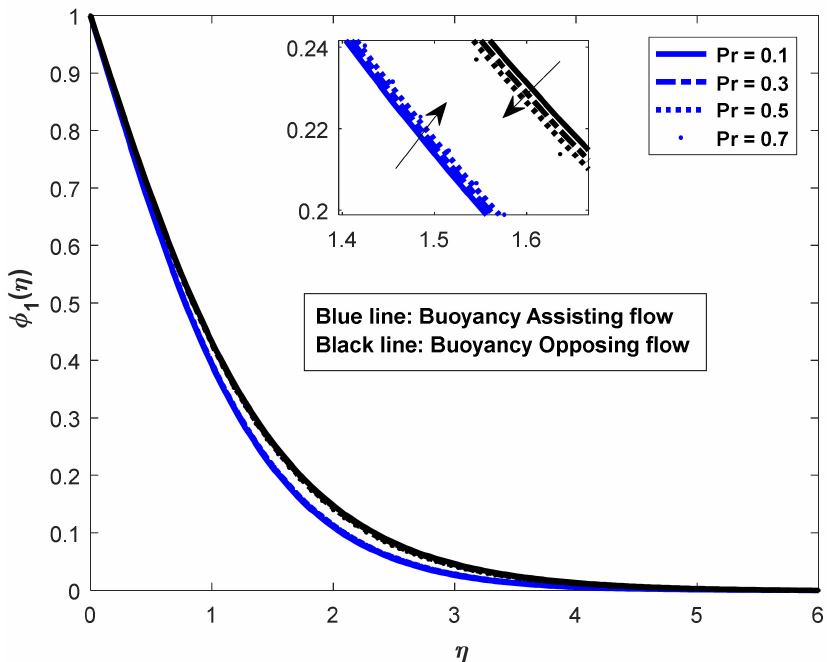
Figure 7. Pr on salt_1 concentration.